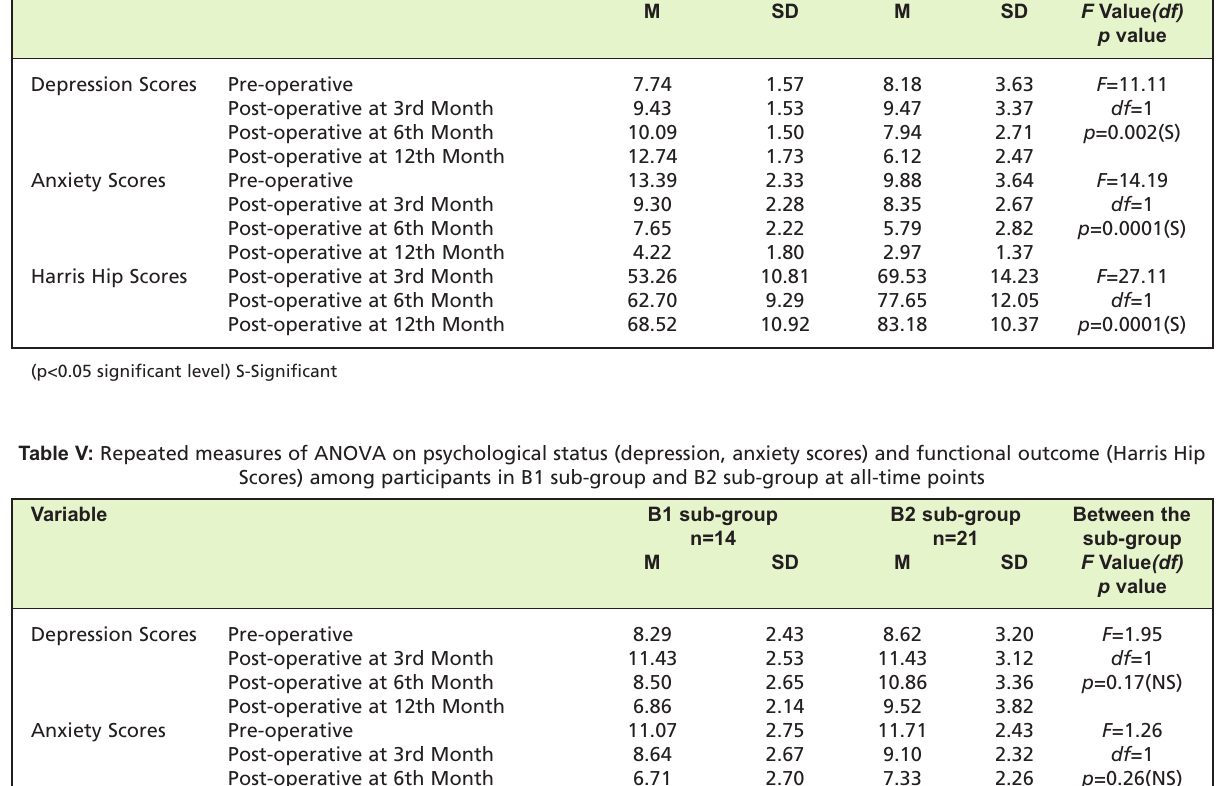
Repeated measures of ANOVA on psychological status (depression, anxiety scores) and functional outcome (Harris Hip Table IV: Scores) among participants in A1 sub-group and A2 sub-group at all-time points Variable